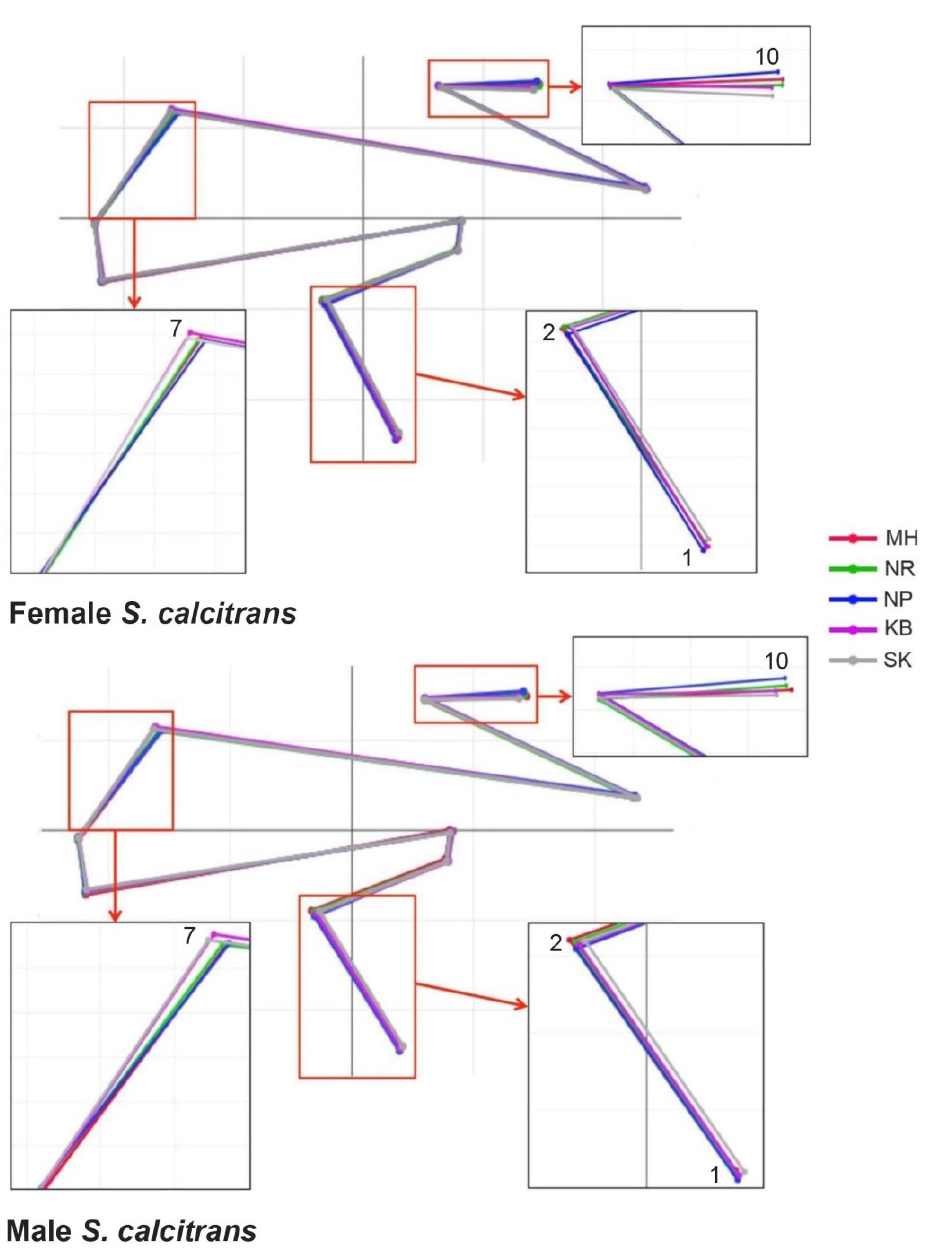
Figure 5. Superposition of the aligned mean anatomical landmark positions of female ( top ) and male ( bottom ) S. calcitrans populations. Enlarged images in small frames showed the parts of wing construction where variation occurred.